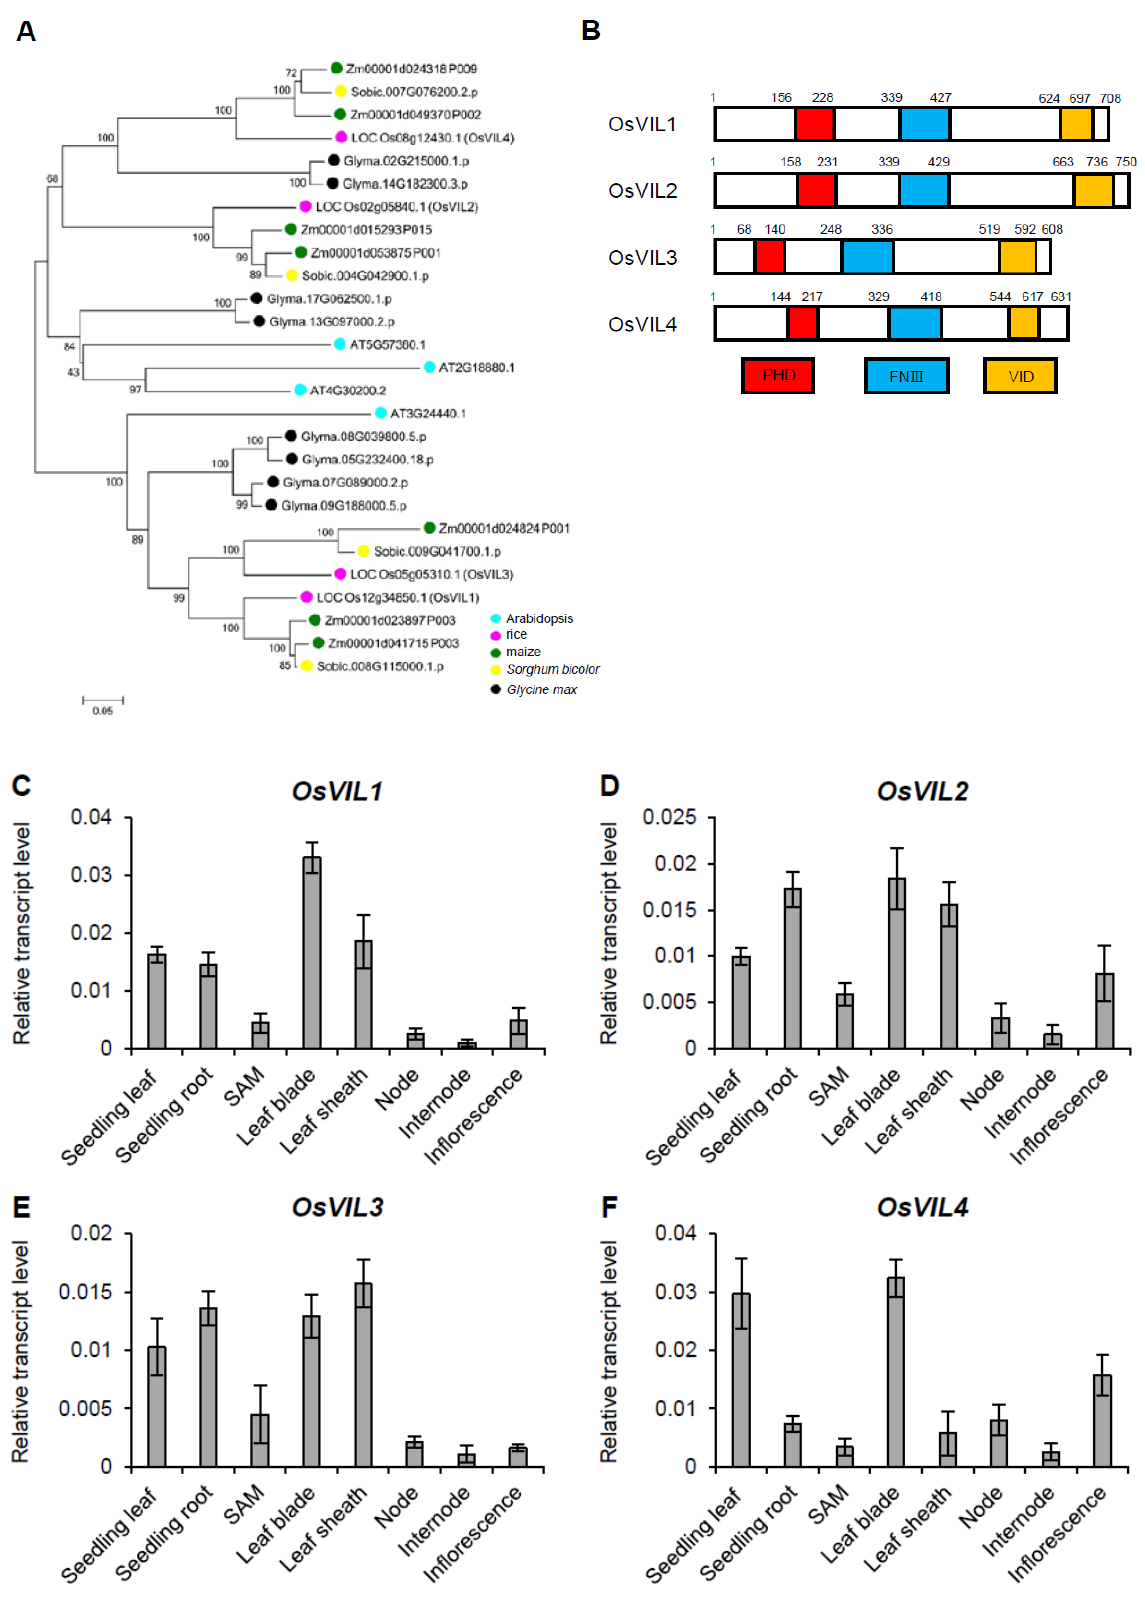
Figure 1. Comparative analysis of OsVIL genes. ( A ) Phylogenetic analysis of proteins OsVIL1–4 in rice, Arabidopsis, maize, Sorghum bicolor , and Glycine max . ( B ) Protein structures of OsVIL1–4. ( C – F ) Expression levels of OsVIL1 ( C ), OsVIL2 ( D ), OsVIL3 ( E ), and OsVIL4 ( F ) in various tissues. Rice Actin1 was used as an internal control. The error bars indicate the standard deviations, n = 4.